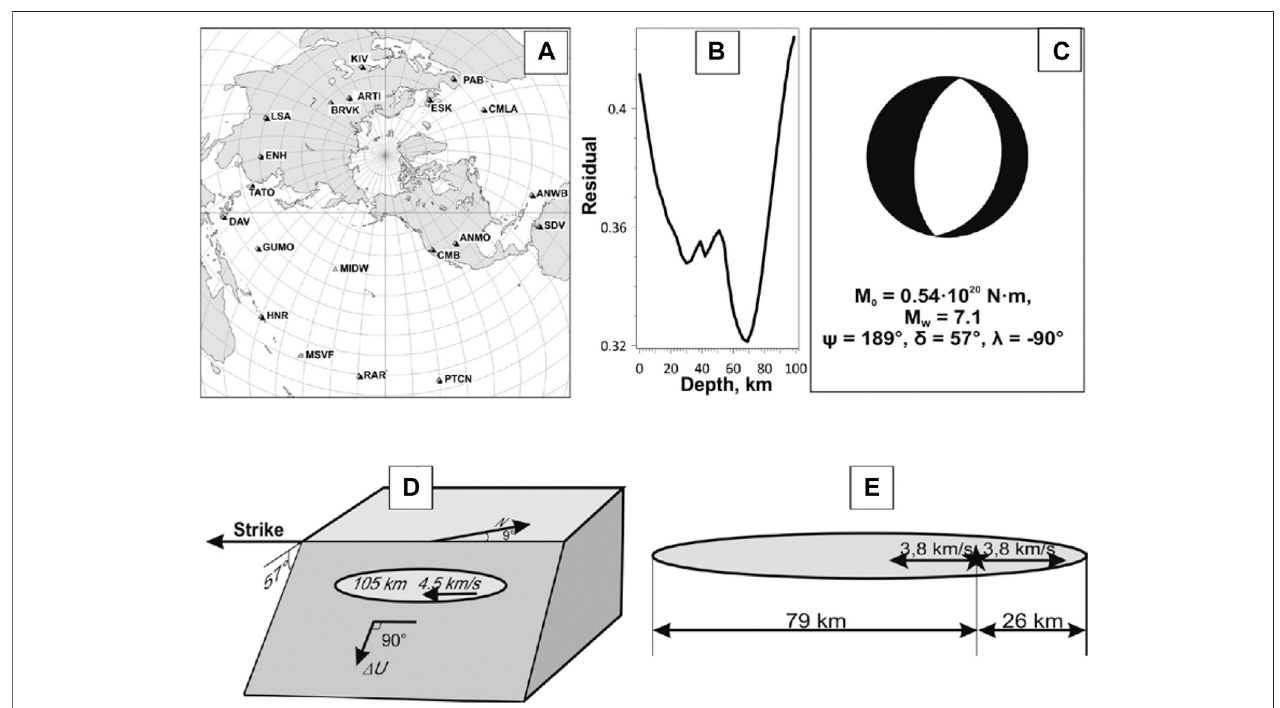
FIGURE 11 | Modeling the November 30, 2018, M W 7.1 earthquake: (A) stations used to determine parameters of the earthquake in the double couple approximation, (B) source depth residual function, (C) focal mechanism, (D) the earthquake focal model, (E) one-dimensional bilateral model of faulting oriented along the centroid velocity. Notes: the same as in Figure 8